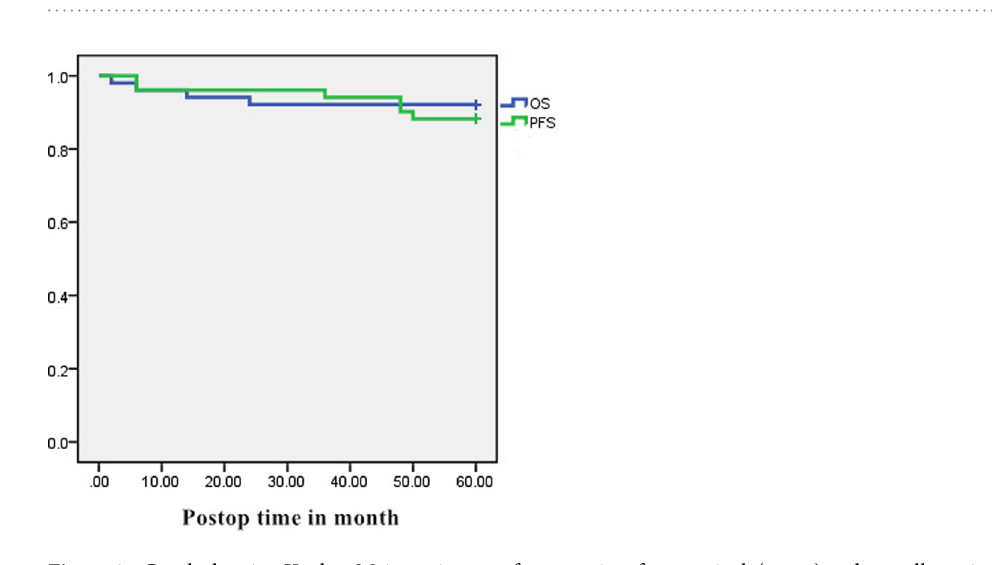
Figure 2. Graph showing Kaplan-Meier estimates of progression-free survival. (green) and overall survival (blue).